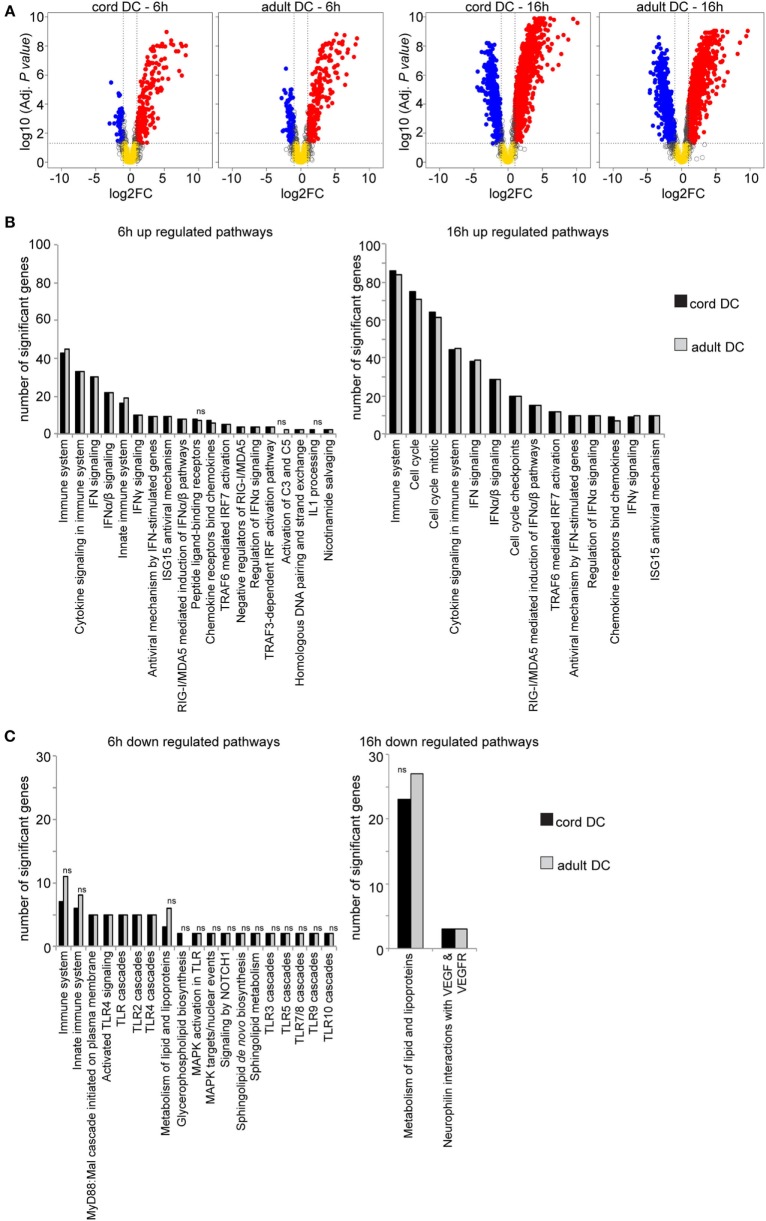
HCMV-infected cord-derived DCs display an activated antiviral pathway response dominated by IFN-induced cytokine signaling, increased cell-cycle activation, and a suppression of lipid metabolism. Volcano plots showing the genome-wide expression profile in cord and adult-derived DCs upon 6 and 16 h of HCMV infection (A). Graphs visualizing the over-represented pathways (ORA), and the number of significantly expressed genes grouped within each ORA, present among the significantly upregulated genes (B) and significantly downregulated genes (C) at 6 and 16 h postinfection in cord (black bars) and adult (gray bars) DCs (B,C). The genes grouped in Immune system and Metabolism of lipid and lipoproteins are further sub-categorized into several immune system and lipid metabolism-related pathways. Pathways not identified in one of the two datasets (but present in the other), or pathways with non-significant corrected p-values (p > 0.05), are marked with “ns”.